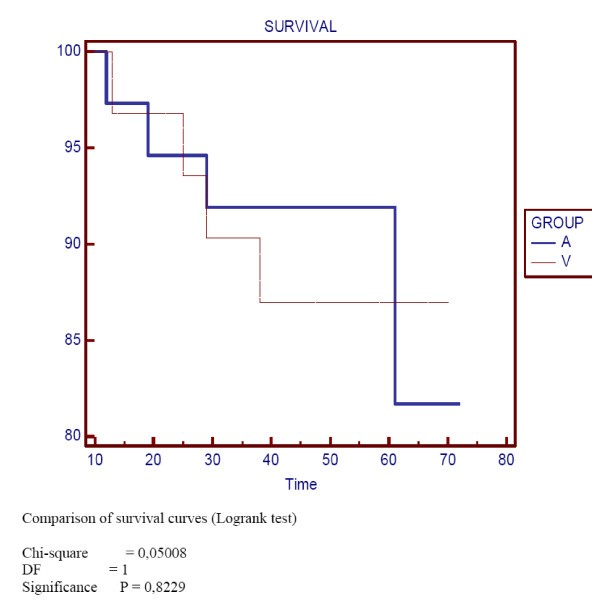
Overall survival.